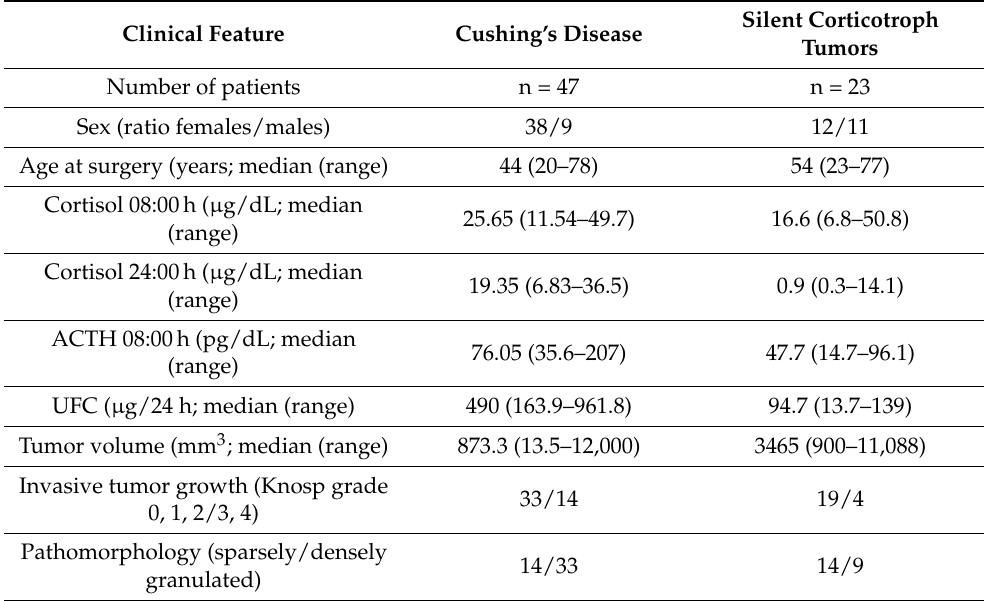
Table 1. Summary of clinical features of patients with Cushing’s disease and silent corticotroph